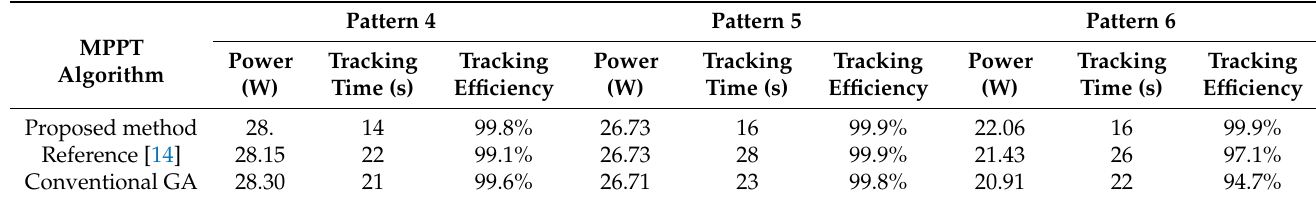
Table 6. Experimental results for Patterns